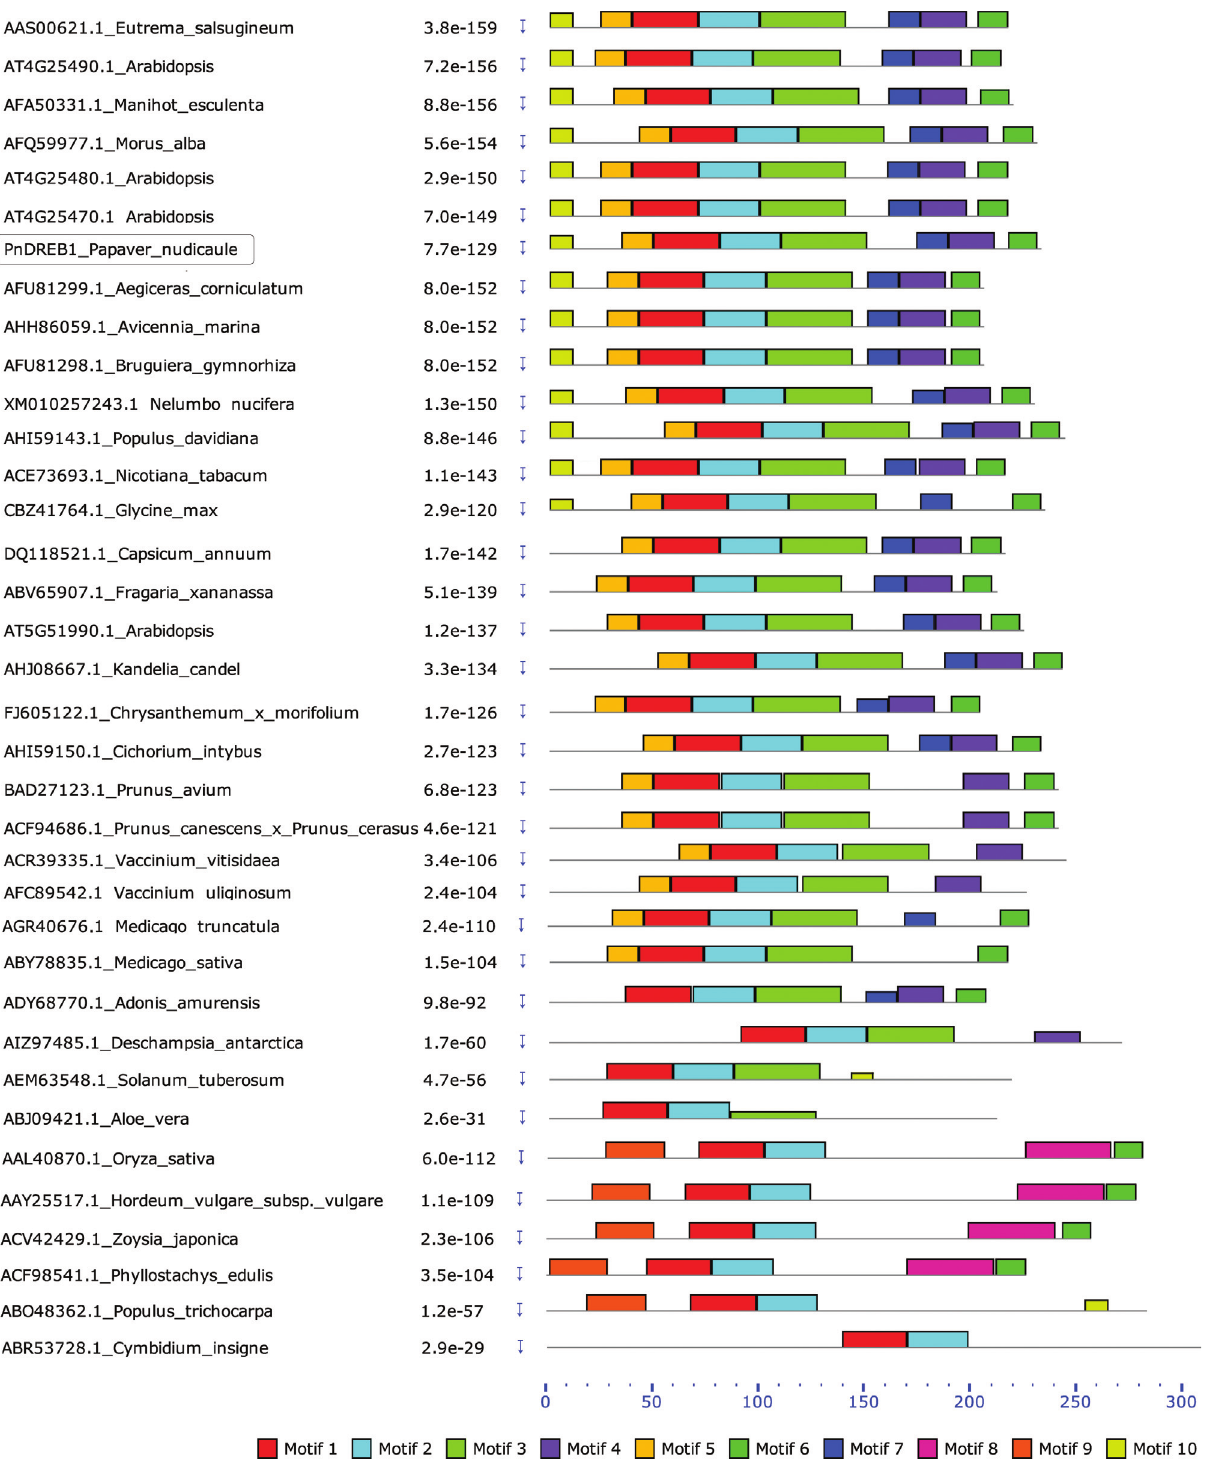
Figure 2 - Comparison of protein motifs of 35 DREB1s from diverse dicot and monocot species. The PnDREB1 is